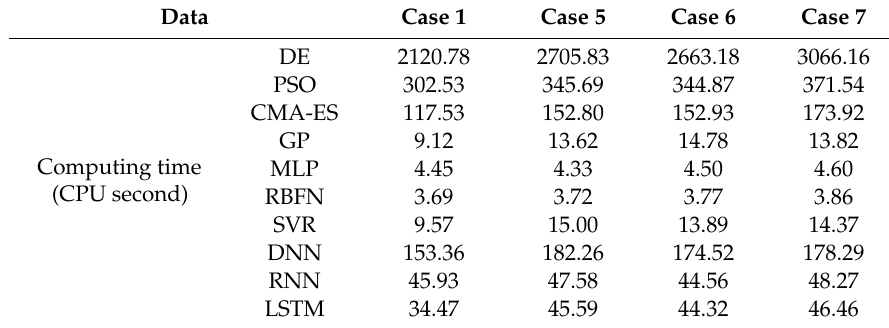
Table 7. Computing time for Seosan data.